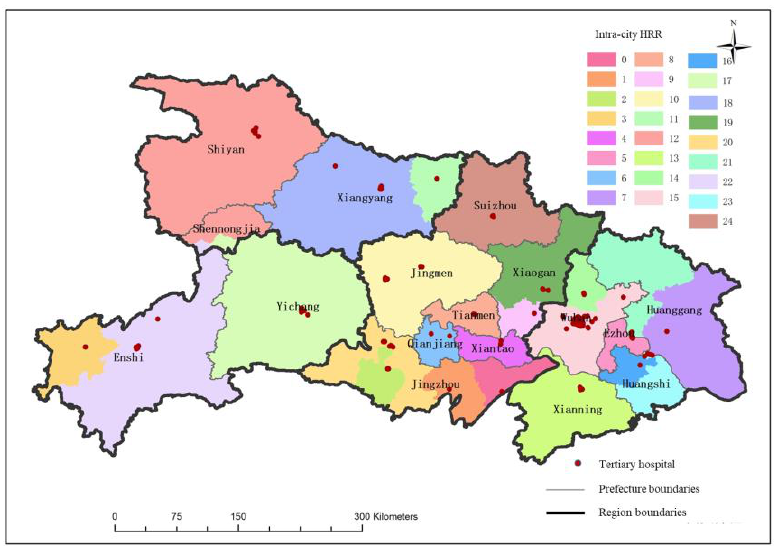
Figure 7. The intra-city HRR.